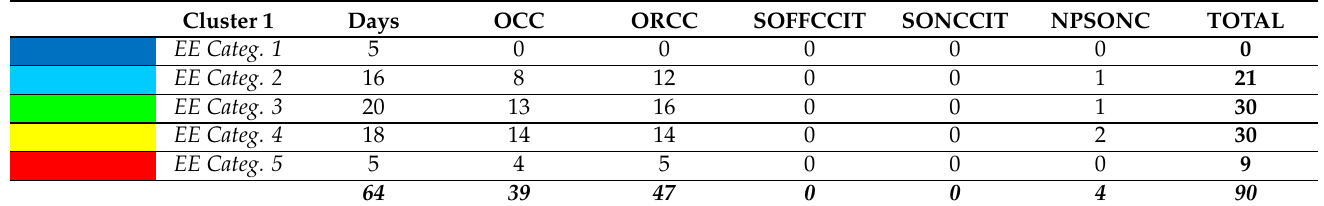
Table 7. Cluster 3.3 anomaly distribution. Each EE Category is associated with a color as depicted in Figure 12.